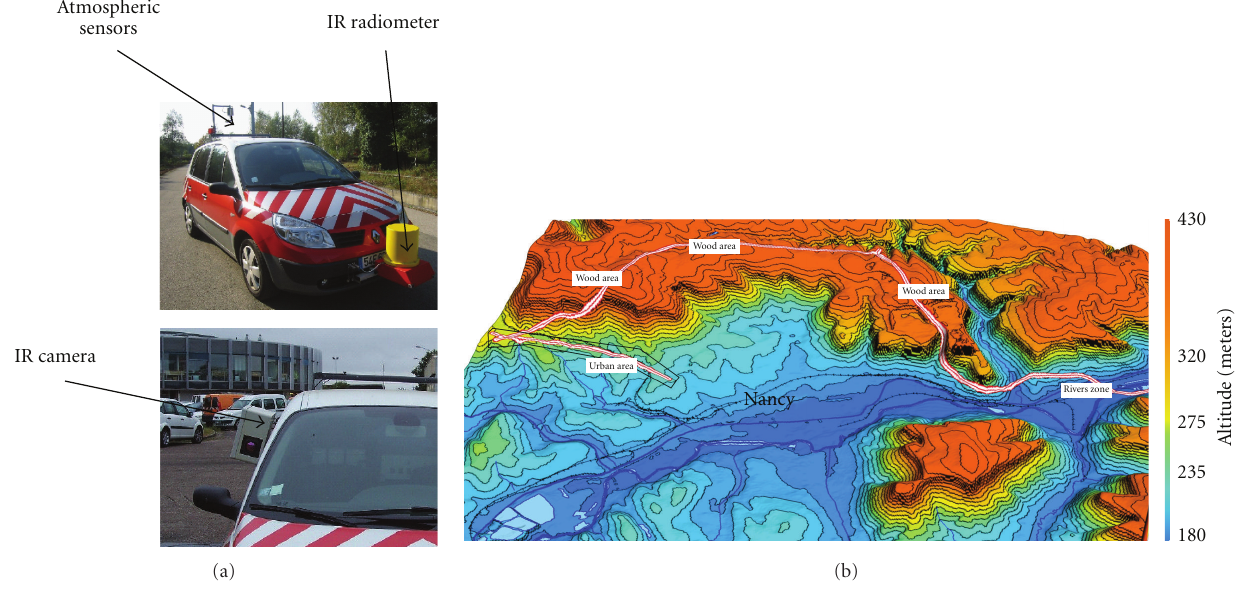
Figure 1: Vehicle for thermal mapping (a); map of the road network investigated (from 180m (blue) to 430m (red) (b). (presence of bridges, urban areas, woods on road sides, pavement nature changes, etc.) that might help in the analysis of road thermal response.